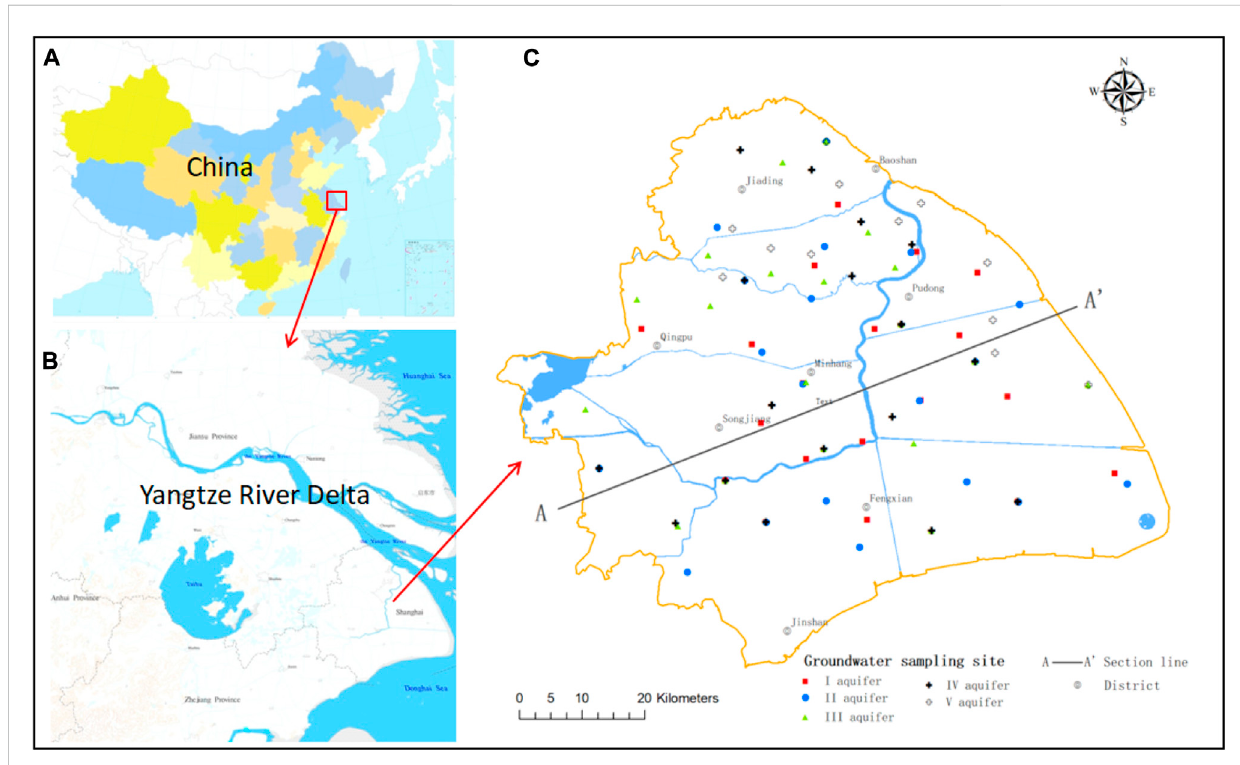
FIGURE 1 Map of the study area showing groundwater sampling points. (A) Map of China. (B) Map of the Yangtze River Delta. (C) Map of